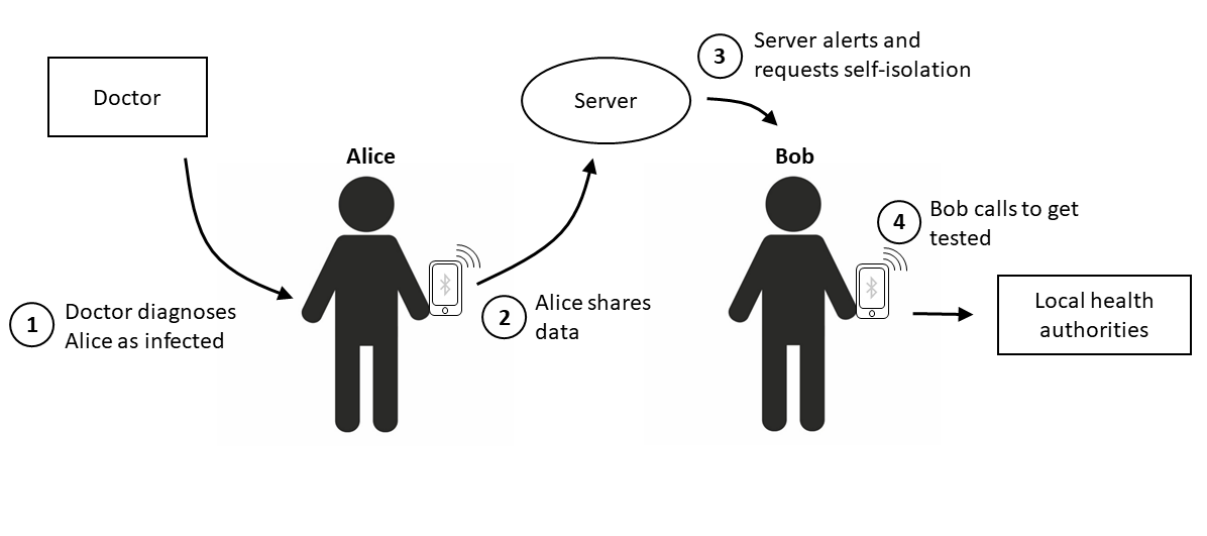
Figure 2. A user can share their data with the server after receiving a COVID-19 diagnosis. The server then alerts all phones that have been in close proximity to the infected phone. The alerted people would still need to contact their local health authorities, as their identity is not linked to the